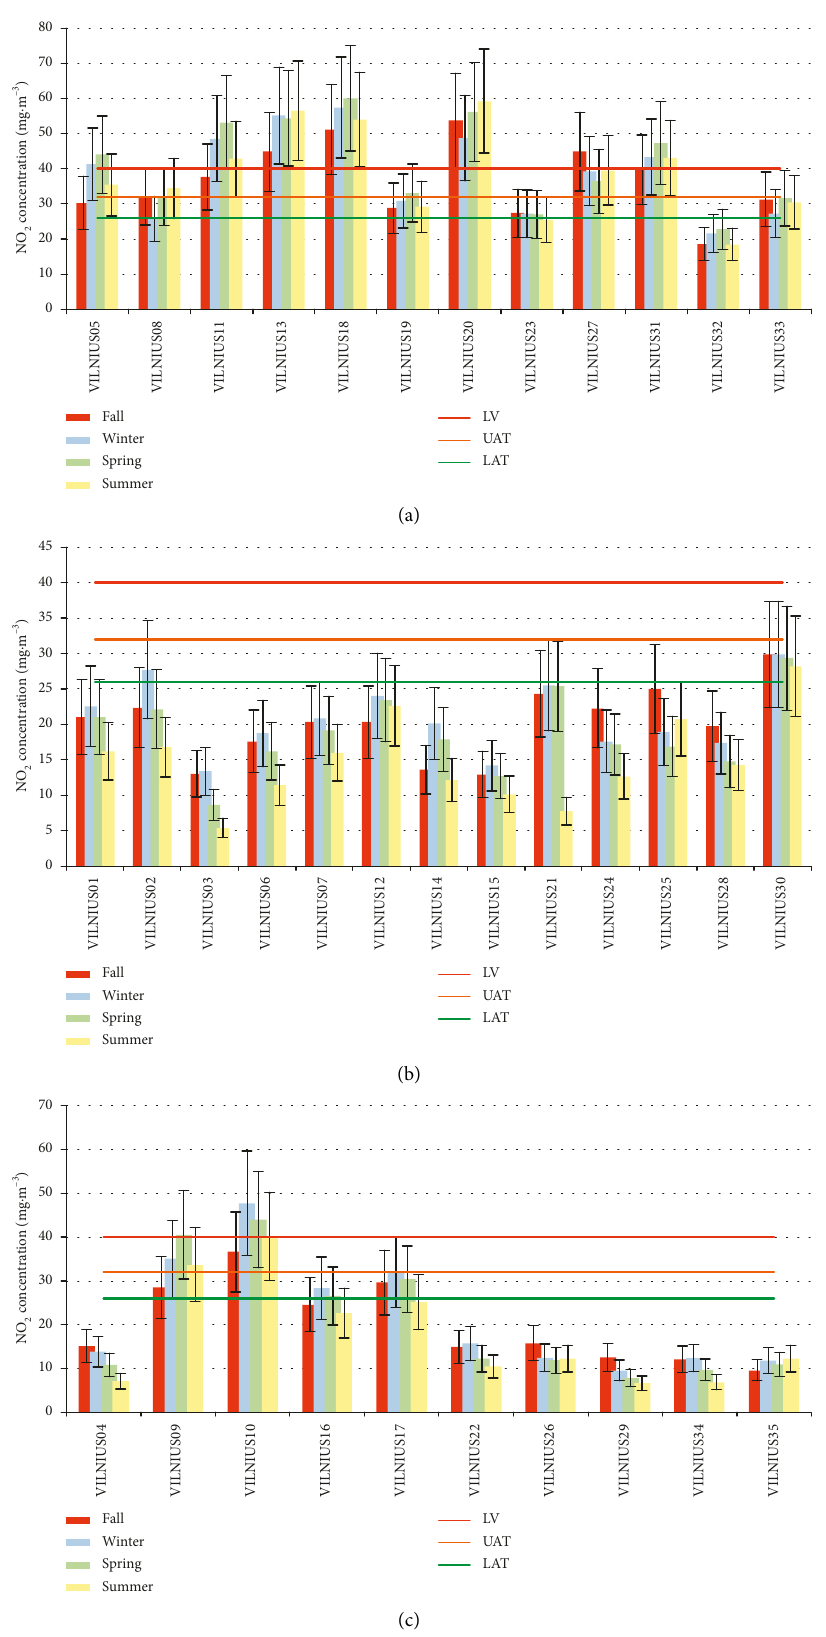
Figure 5: Seasonal variation of mean nitrogen dioxide concentrations at site-specific areas for the entire study period from 3 November 2010 to 4 July 2011 (bar lines show 21.6% expanded uncertainty). (a) Vilnius, transport. (b) Vilnius, residential. (c) Vilnius, ±